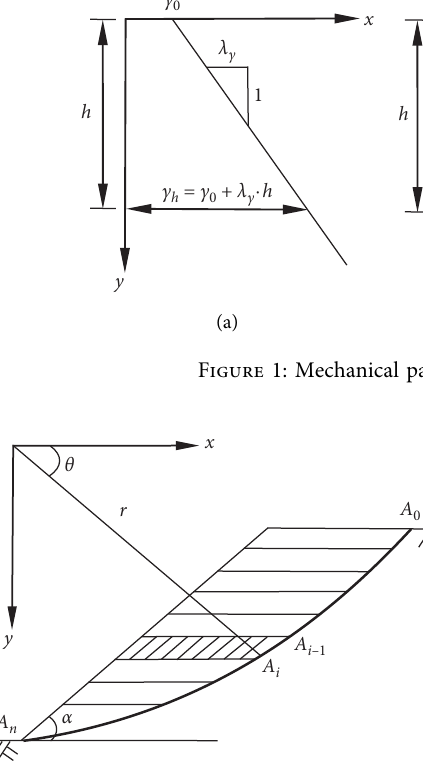
Figure 2: Slope failure